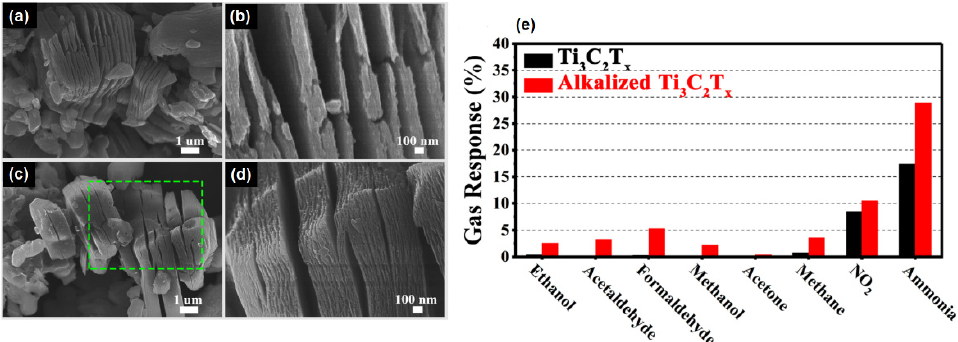
Figure 12. Morphology and sensor response of Ti 3 C 2 T x and alkalized Ti 3 C 2 T x : ( a , b ) SEM images of Ti 3 C 2 T x ; ( c , d ) SEM images of alkalized Ti 3 C 2 T x ; ( e ) gas sensor response of Ti 3 C 2 T x and alkalized Ti 3 C 2 T x to the test gases with a concentration of 100 ppm. Reprinted with permission from [82]. Copyright © 2019, American Chemical Society.